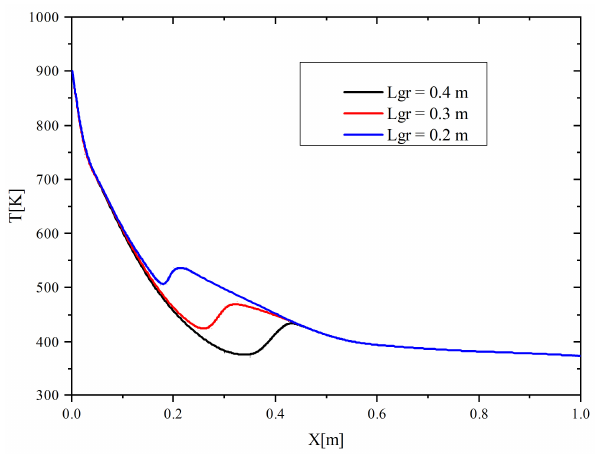
Figure 4. Forest fuel surface temperature at different control line spans. The distributions of the forest fuel surface temperature on the coordinate parallel to this surface, presented in Figure 4, can be tentatively divided into three regions corresponding to certain variations of the temperature T